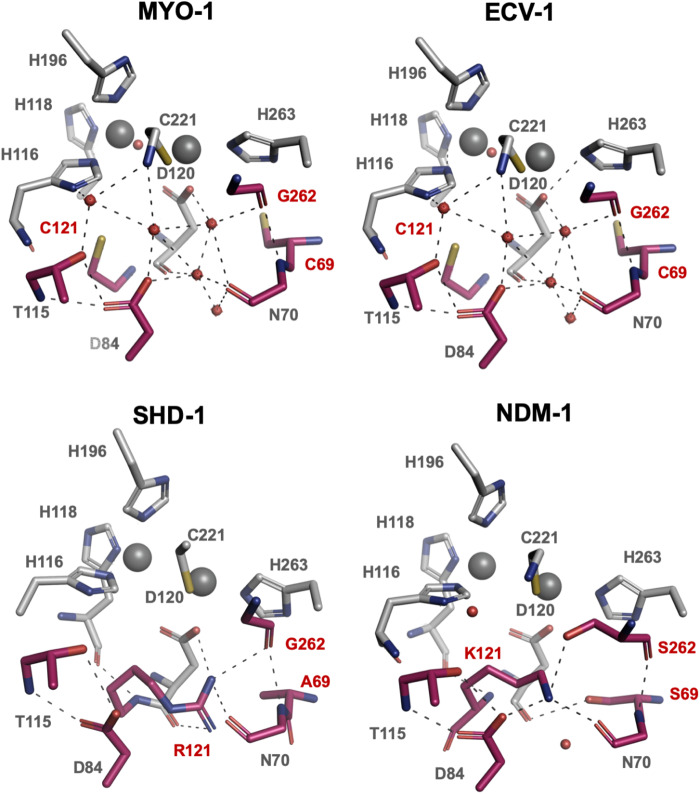
First and second shell residues of MYO-1, ECV-1, SHD-1 and NDM-1. First shell residues are displayed in grey and second shell residues are shown in red. Labels of amino acids varying between these four enzymes at positions 69, 121 and 262 are displayed in red. The lack of K121 or R121 in MYO-1 and ECV-1 is compensated for by water molecules.